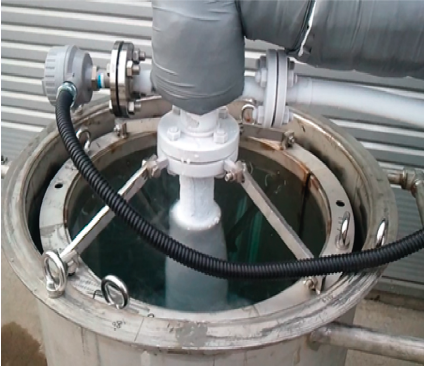
Figure 3: Water freezing experiment.